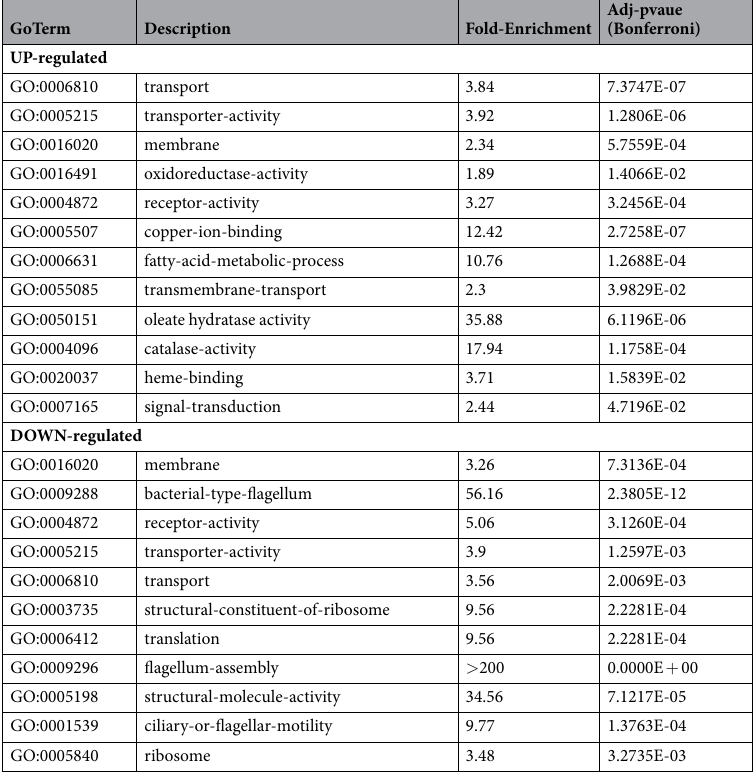
Table 1. Functional Enrichment analysis. GO terms showing significant over-representation in differentially expressed genes sets, with associated counts and adjusted